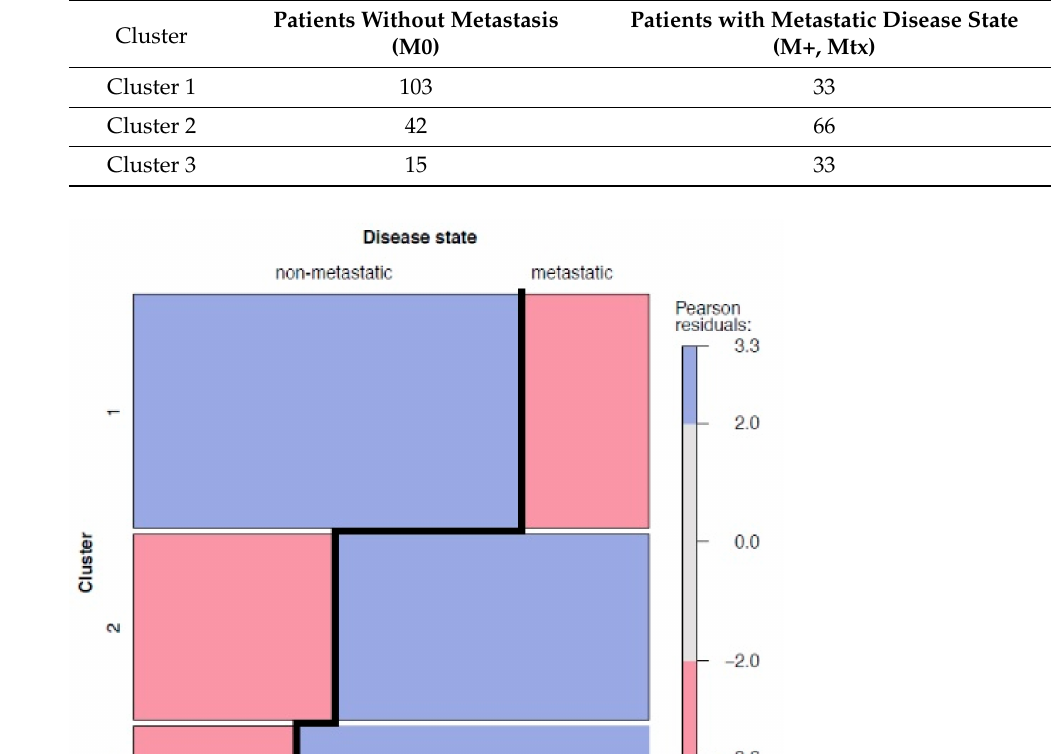
Table 5. Matching of unsupervised clustering and metastatic disease state.